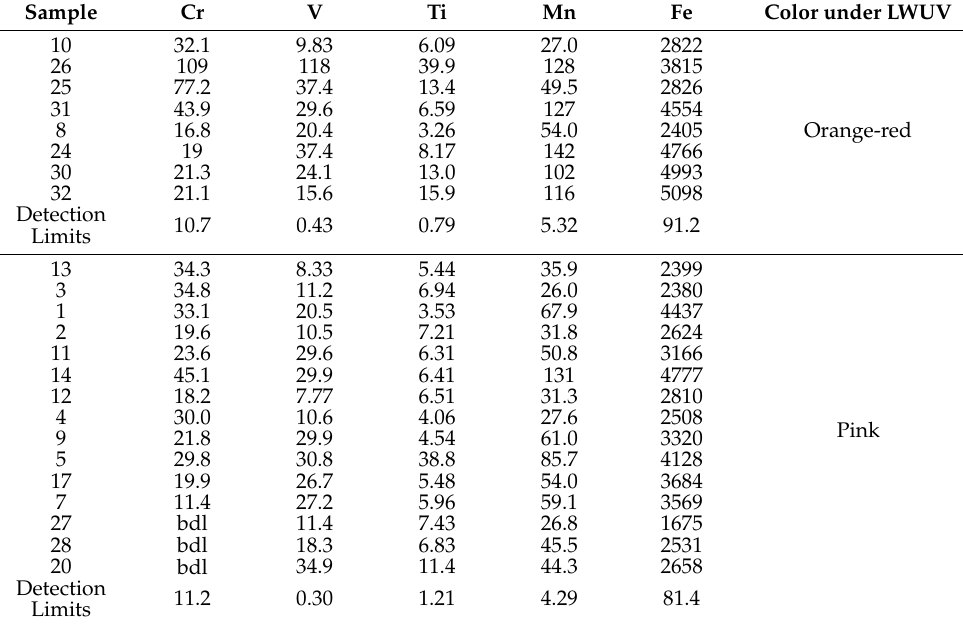
Figure 7. Two-dimensional fluorescence spectra of taaffeites using 369 nm excitation. ( a ) Samples with orange-red fluorescence under LWUV. The red region of fluorescence spectra had been enlarged for better analysis, which placed on the left side. ( b ) Samples with pink fluorescence under LWUV. The red region of fluorescence spectra had been enlarged for better analysis, which placed on the left side. ( c ) Samples with green fluorescence under LWUV. ( d ) Samples with blue-white fluorescence under LWUV. Table 1. Contents of trace elements in samples with orange-red and pink fluorescence under LWUV